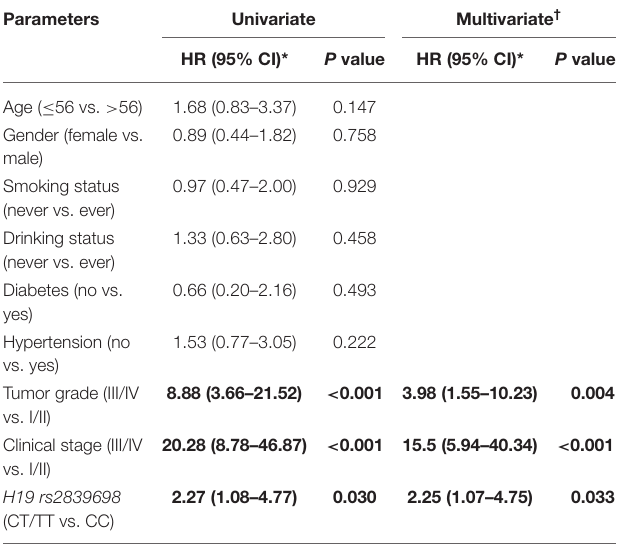
TABLE 4 | Univariate and multivariate Cox proportional hazard analysis of death risk in patients with RCC. Parameters